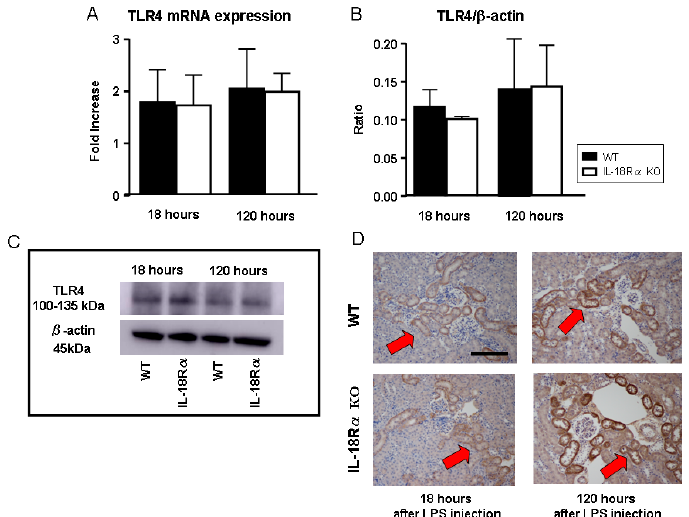
Figure 6. Effect of IL-18R α on TLR4 in LPS-induced AKI. The gene expression ( A ), protein levels ( B ) and tubular staining of TLR4 ( D ) in WT and IL-18R α KO mice at 18 ( n = 11, n = 10) and 120 h ( n = 16, n = 6) after LPS injection were assayed by real-time PCR, Western blotting and immunohistochemistry. ( C ) A representative band of TLR4 and β -actin. In the immunohistochemical staining ( D ), TLR4 + cells were present in the dilated tubules, indicated by red arrows ( × 400) in the WT and IL-18R α KO mice at 18 and 120 h after LPS injection. The data are the mean ± SEM. Photomicrographs: × 400. Scale bar, 50 µ